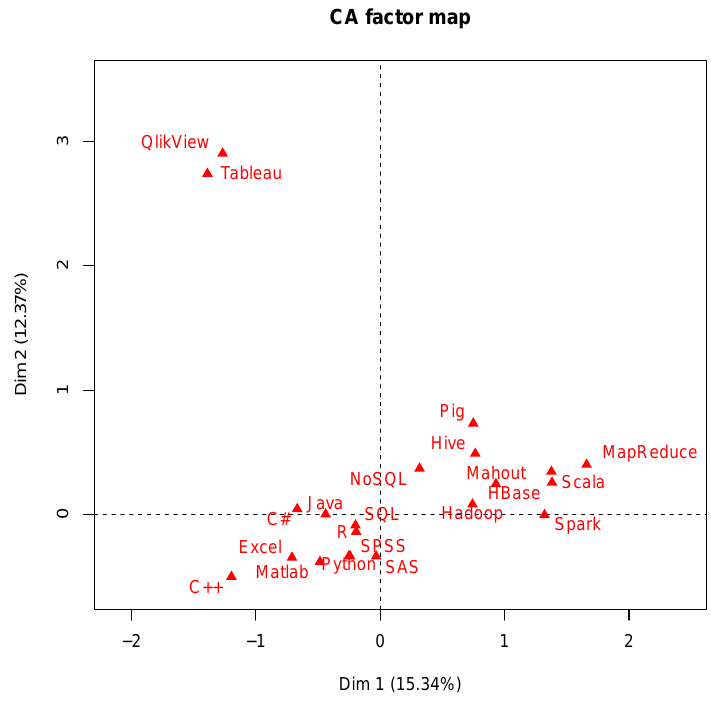
Figure 1. From 60 Data Scientist job advertisements, non-empty from the initial set of 72 employers, with use of 21 software languages or environments. The latter were required by at least four employers. Displayed is the principal factor plane.